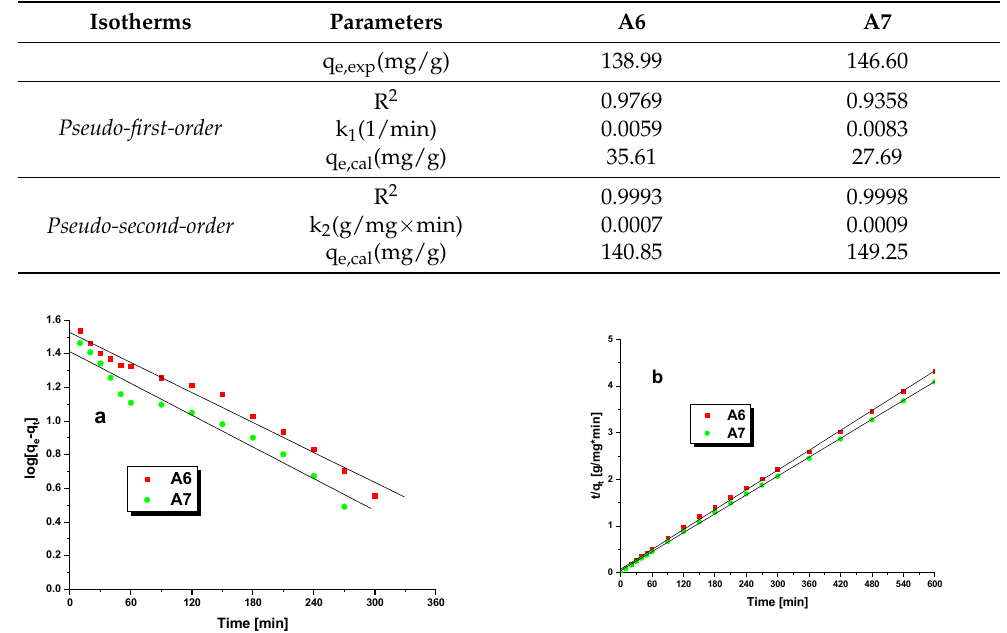
Figure 10. Pseudo-first-order ( a ) and pseudo-second-order ( b ) kinetic plots for adsorption of methy- Figure 10. Pseudo ‐ first ‐ order ( a ) and pseudo ‐ second ‐ order ( b ) kinetic plots for adsorption of meth ‐ lene blue on samples A6 and ylene blue on samples A6 andA7.